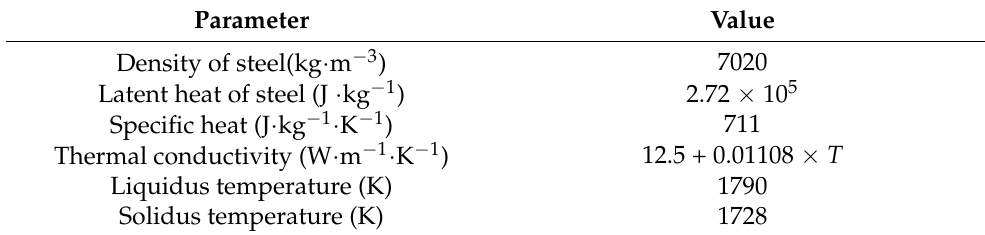
Table 2. Thermophysical properties of S355 steel used in the study.